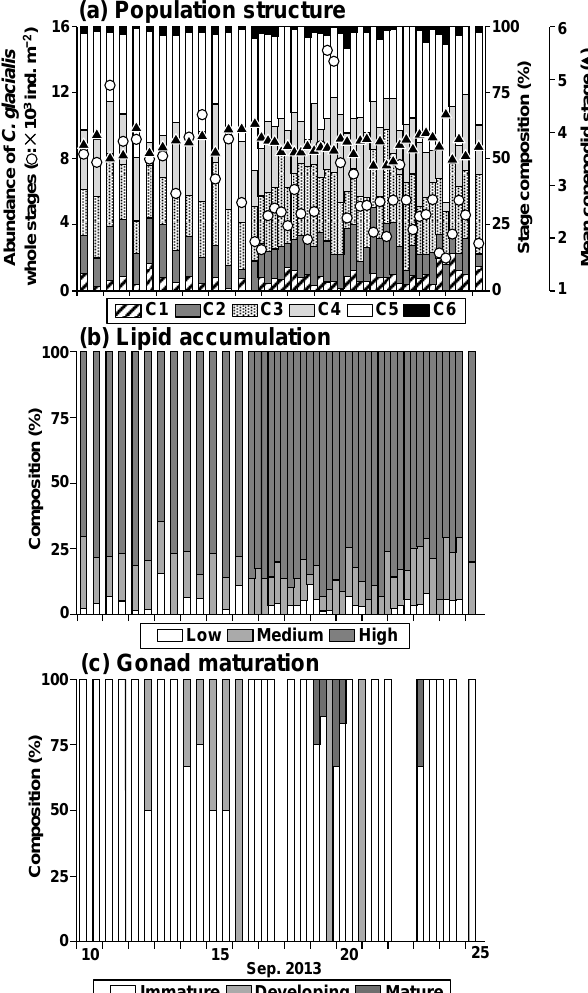
Figure 3. Temporal changes in the population structure (a) , lipid ac- cumulation of C5 (b) and gonad maturation of C6Fs (c) of Calanus Fig. 3 (Matsuno et al.) glacialis at a fixed station in the Chukchi Sea from 10 to 25 Septem- ber Figure 2. Temporal changes in the temperature (a) , salinity (b) and Fig. 2. (Matsuno et al.) chlorophyll a (c) and T - S diagram (d) at a fixed station in the